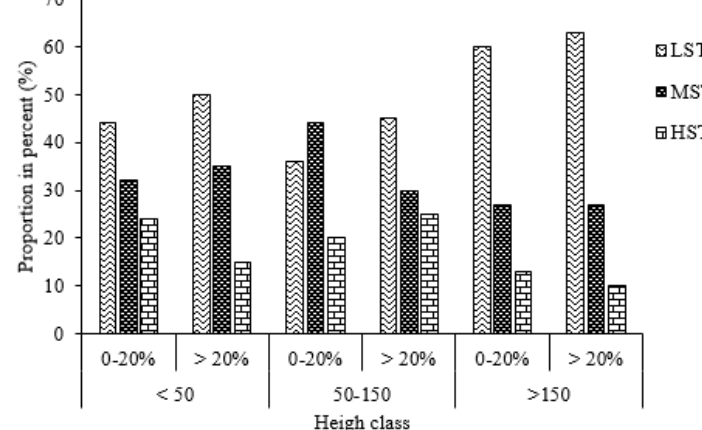
Figure 6. The proportion of seedlings measured in height classes with the effect of slope and traffic intensity on skid trail. HST: skid trail with high traffic intensity; MST; skid trail with medium traffic intensity; LST; skid trail with low traffic intensity.